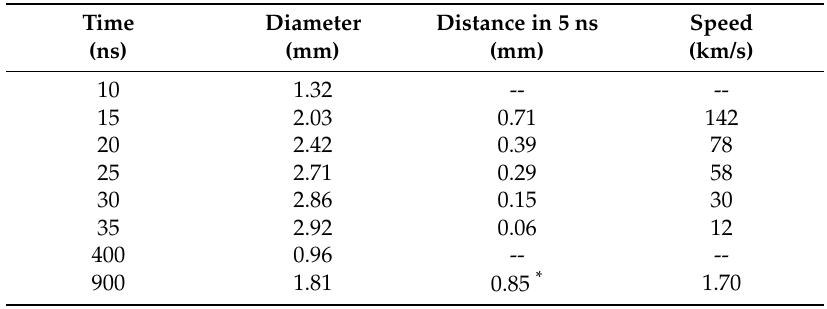
Table 1. Plasma expansion speed at various time delays using lateral direction expansion from the contour plots exhibited in Figures 1 and 2.